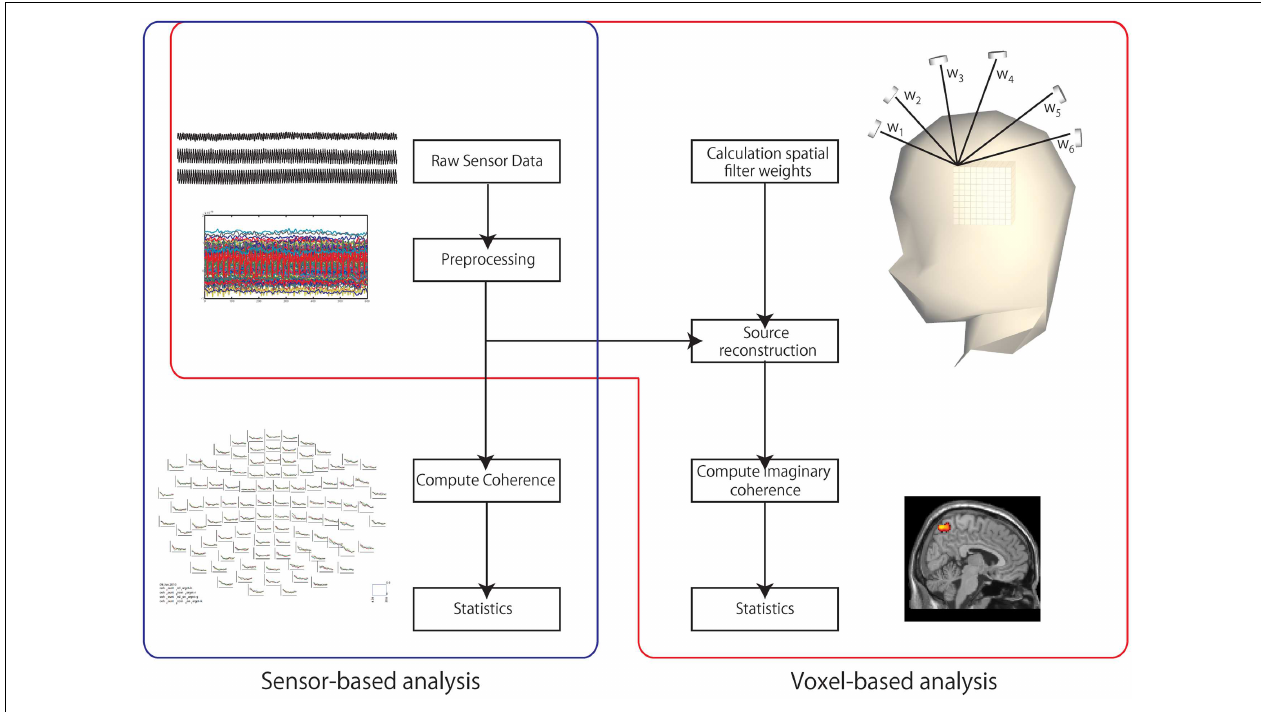
sensor data were first projected to voxel space. Second, the mean imaginary coherence was computed. Finally, the projected data were transformed to a standard